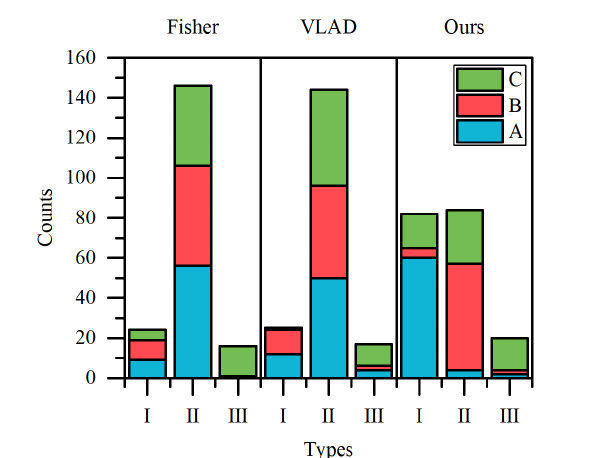
Figure 2 The situation analysis of the global descriptors experimental